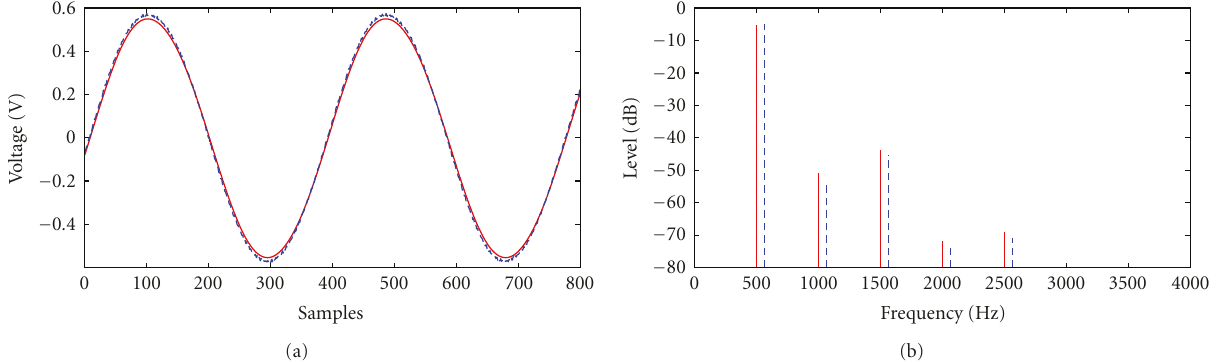
Figure 10: Comparison between the real-world output of pedal 2 (blue-dashed) and the GPH model-based output (red-solid) in time (a) and frequency (b) domains, for a sine wave excitation with f 0 = 500 Hz and A 0 = 0 . 5 V. The GPH model is estimated using a swept sine signal with amplitude A s = 1 V. For the sake of clarity, the output of the real-world device in the frequency domain is shifted to the right.